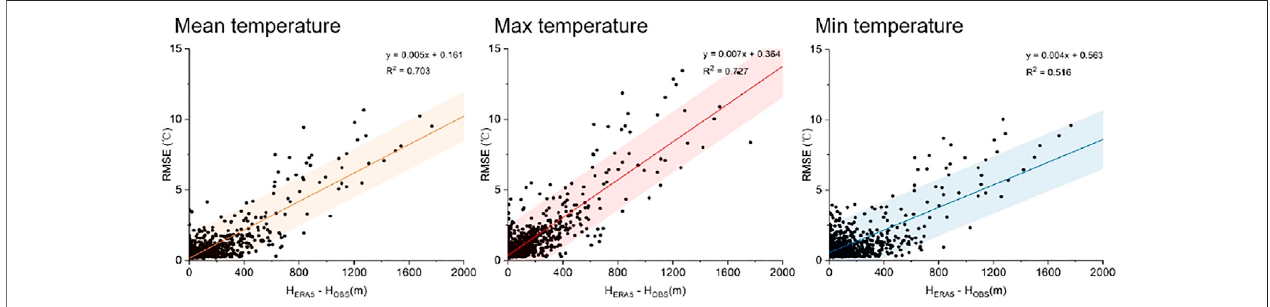
FIGURE 10 | Linear regression of the RMSE and elevation gaps between stations and ERA5 reanalysis. Shading shows the prediction bands at the 95% con fi dence